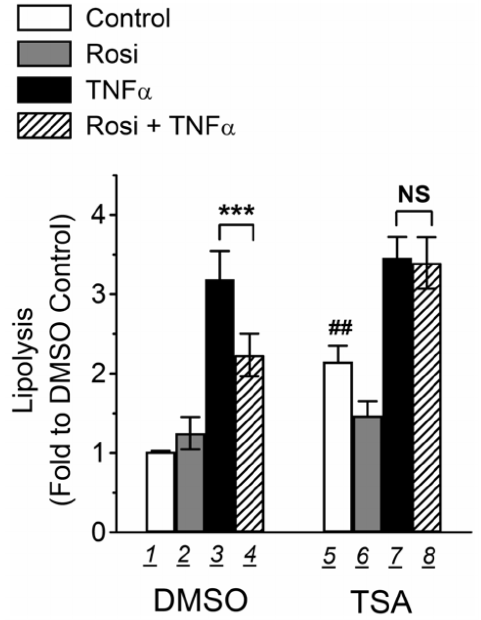
Figure 1. TSA treatment attenuates Rosi suppression of TNF a - induced lipolysis in 3T3-L1 adipocytes. 3T3-L1 adipocytes were treated with vehicle (Control), 1 m M Rosi (Rosi), 10 ng/ml TNF a (TNF a ), or both (Rosi + TNF a ), together with vehicle (DMSO, bars 1-4) or 660 nM TSA (TSA, bars 5-8) for 24 h. Glycerol released into the media and protein concentrations of cell lysate were determined as described in Materials and Methods . Each point represents the mean 6 S.E. of seven independent experiments. Asterisks denote significant differences (***p , 0.001). NS, not significant. ## p , 0.01 bar 5 vs 1.